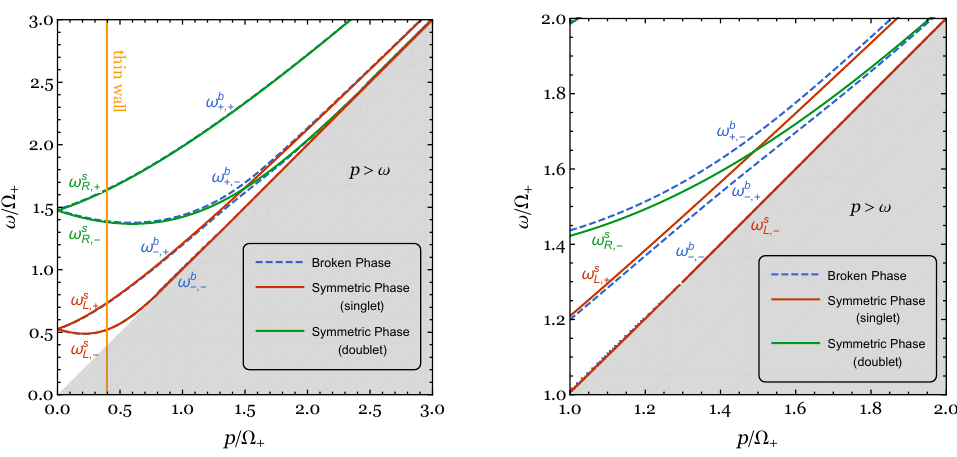
Figure 5 . Dispersion curves of the left (green solid) and right-handed (red solid) E lepton in the symmetric phase and those in the broken phase (blue dashed) for y E = 0 . 015 , g R = 1 . 2 , and v R ( T c ) /T c = 3 . In the left panel, the momenta to the left of the orange solid line satisfy the condition of the thin-wall approximation, p < l − 1 = T n / 10 . The right panel focuses on the level- w crossing